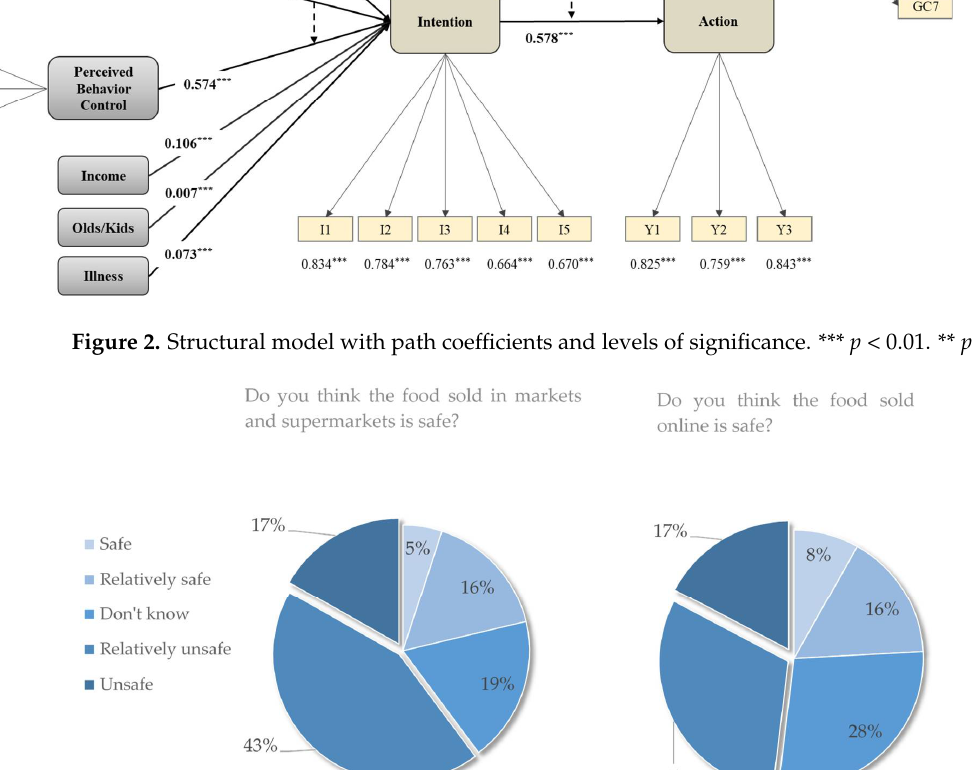
Figure 4. Respondents’ perception of various benefits of organic food. 4.5. Moderating Effect of Satisfaction with Government Regulation In order to explore the moderating effect of residents’ satisfaction with government regulation on the formation of consumption willingness of organic food and the trans- formation of willingness into behavior, two moderator variables, i.e., the satisfaction with the government’s food production support work (GP) and with the government’s food consumption guarantee work (GC), are set according to the derivation of 2.3 in this paper. GP mainly regulates the influence paths of behavior attitude and perceived be- havior control on consumption willingness, and GC regulates the influence path of con- sumption willingness on consumption behavior. All the answers related of participants are shown in Figure 5. Table 5 shows the interesting results: in terms of overall effect, residents’ satisfac- tion with government’s food production support work has a positive impact on the will- ingness to consume organic food (β = 0.243), which verifies the hypothesis H2a. Howev- er, from the perspective of moderating effect, the satisfaction with government regula-